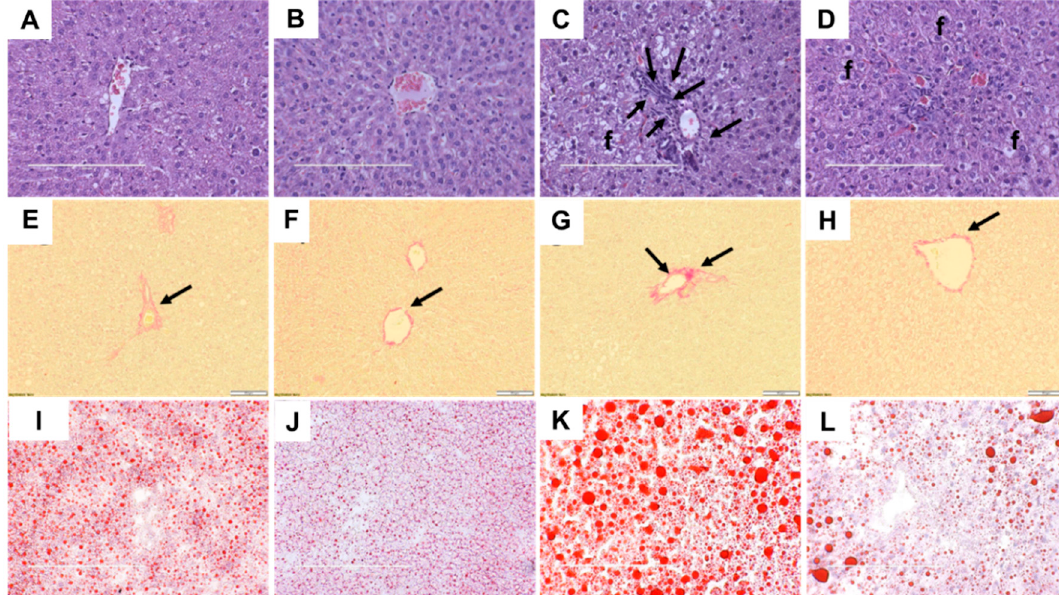
Figure 4. Haematoxylin and eosin staining of liver indicating inflammatory cells as dark spots marked by arrow and fat vacuoles marked as “f”) ( A – D ; magnification ×20; scale bar = 200 µm); picrosirius red staining of liver indicating collagen deposition as red stain around blood vessels marked by arrows ( E – H ; magnification ×12.6; scale bar = 100 µm); and oil red O stain of liver showing fat droplets in red ( I – L ; magnification ×12.6; scale bar = 200 µm). Corn starch diet-fed rats ( A , E , I ), corn starch